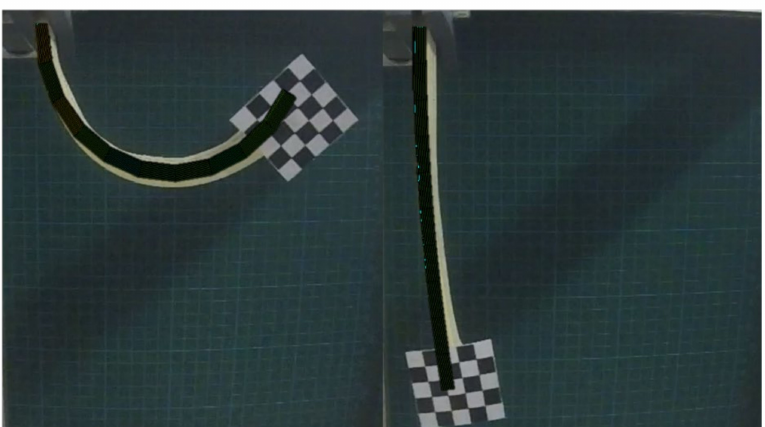
Figure 10. Comparison between the experimental observation and simulated bending deformation of the interactive fiber-elastomer